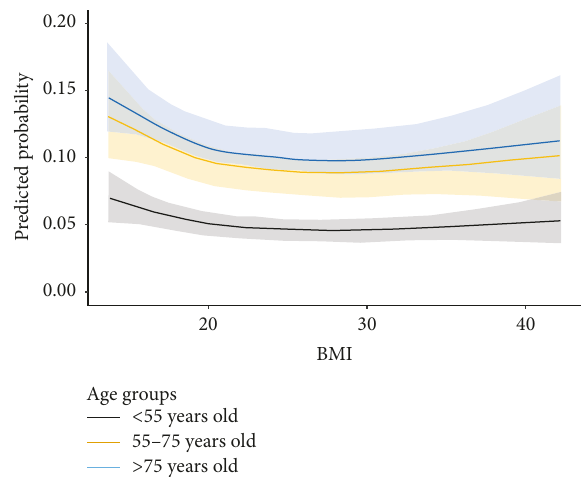
Figure 6: The nonlinear relation between continuous BMI and the probability of having AKI between different age groups by restricted cubic spline regression (total number of patients = 12,555; patients with acute kidney injury = 1606; patients with no acute kidney injury = 10,949). Note . BMI: body mass index; 95% confidence intervals (CIs) are denoted by a grey shadow. Adjusted variables in logistic regression models include age, gender, ethnicity, back- ground diagnoses (cardiovascular disease, chronic kidney disease, diabetes mellitus, hepatobiliary disease, psychiatric illness, and gas- trointestinal disease), primary diagnoses (infectious and parasitic diseases, neoplasm, diseases of the genitourinary system, diseases of the musculoskeletal system and connective tissue, and symptoms, signs, and ill-defined conditions), and procedures (otolaryngology related surgery, endoscopy, open laparotomy, and cardiology related percutaneous